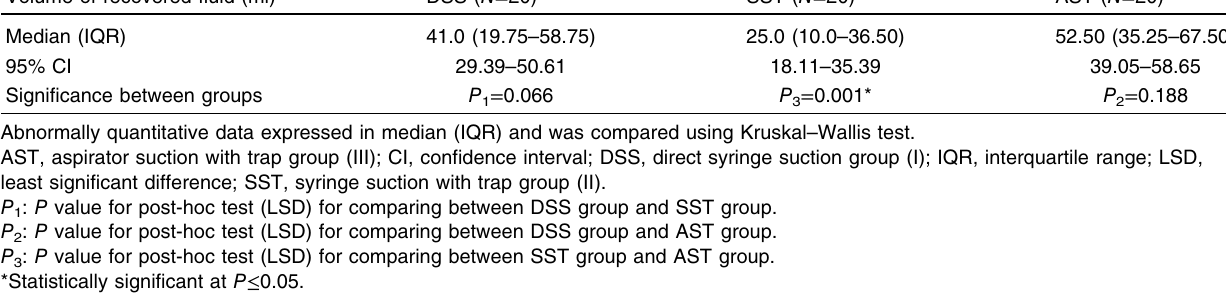
Table 3 Comparison among the three groups according the volume of recovered fluid Volume of recovered fluid (ml)